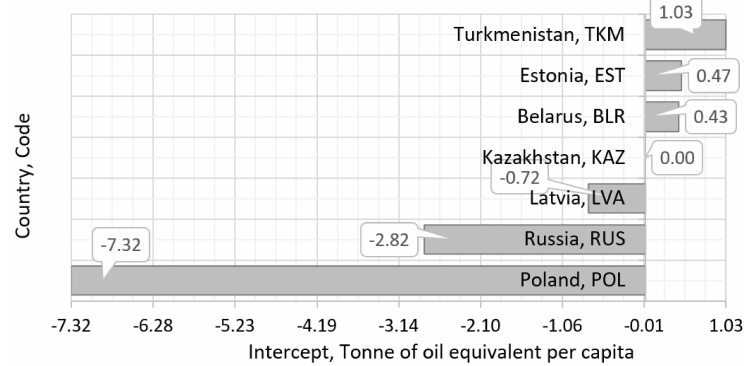
Figure 4. Distribution by segment parameter. Note: developed by the